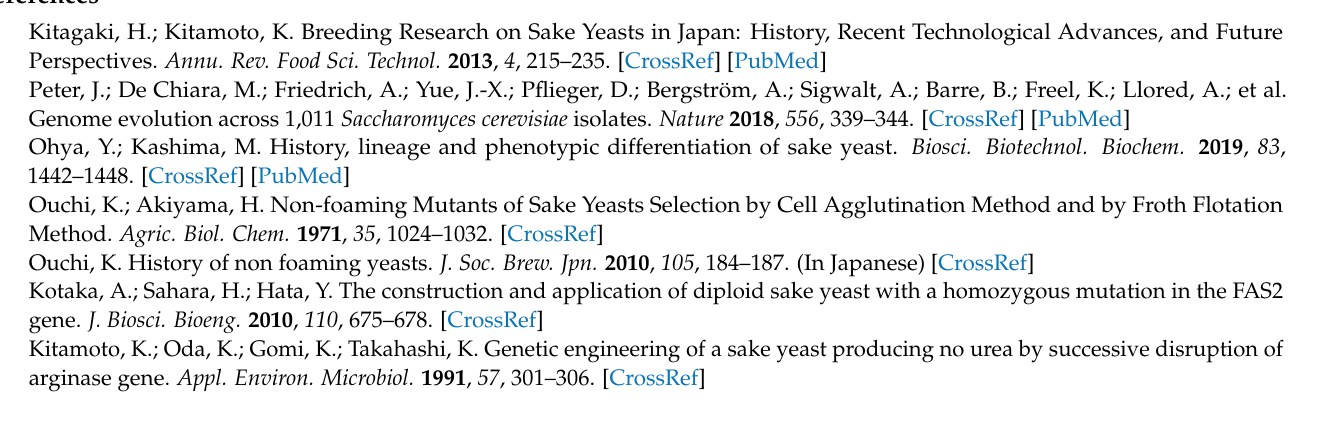
Figure S4: Measurement of isoamyl alcohol (A), 1-propanol (B), succinic acid (C), and lactic acid (D) in sake made with genome-edited strains; Figure S5: Raw data of Figure 2B; Table S1: Oligonu- cleotides used as genome editing tools; Table S2: Oligonucleotides used for polymerase chain reaction; Table S3: Comparison of the whole-genome sequences of genome-edited sake strains; Table S4: The morphological changes at each step detected by likelihood ratio test (FDR =